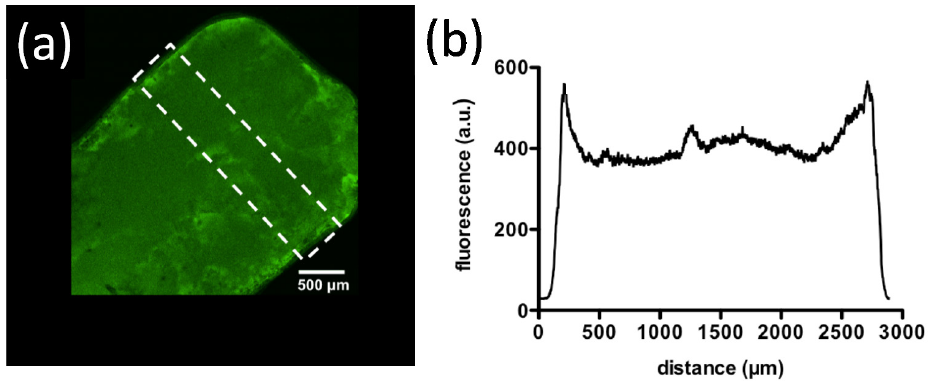
Figure 12. ( a ) Confocal scanning electron microscopy on chitosan gel synthetized by FITC-labeled chitosan along with ( b ) polymer profile through the gelling axis. Reprinted under an open access CC-BY licence [207].